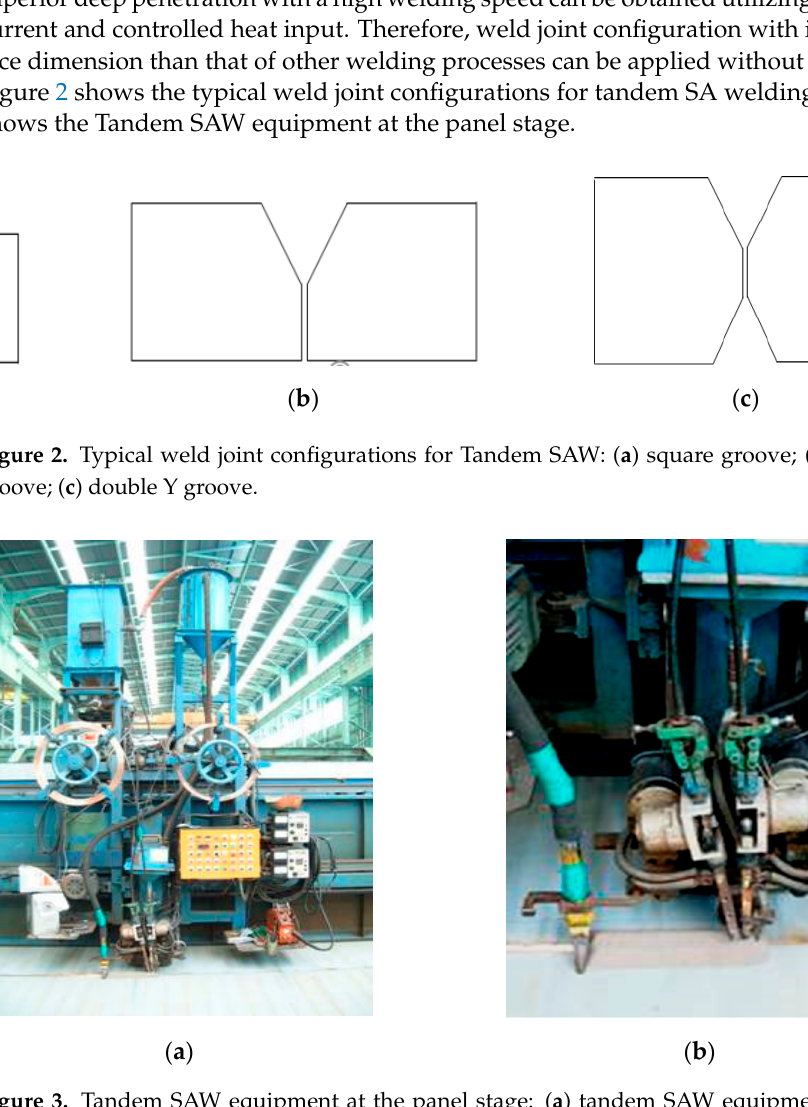
Figure 1. Typical weld joint configurations for arc welding: ( a ) single bevel; ( b ) single vee.